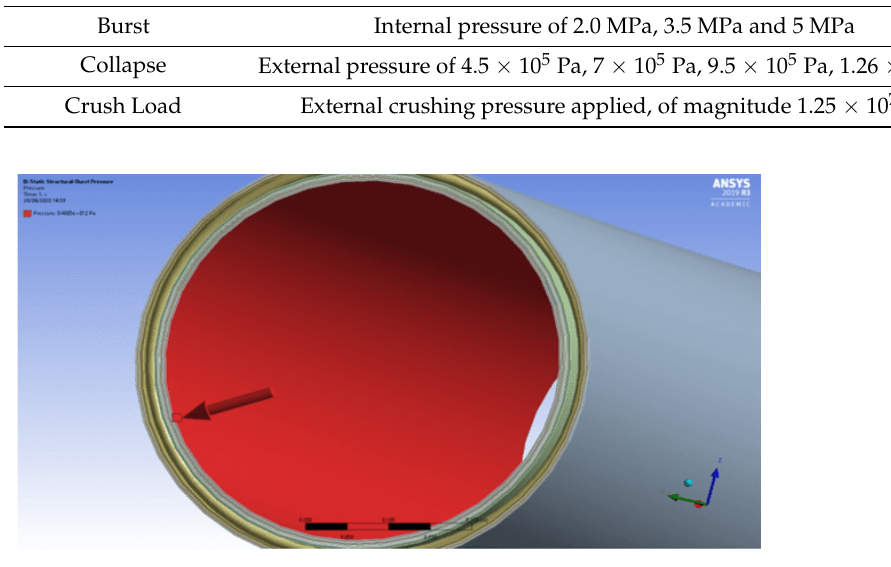
Figure 7. Internal pressure load applied on the offshore hose in ANSYS Static Structural 2019 R3.